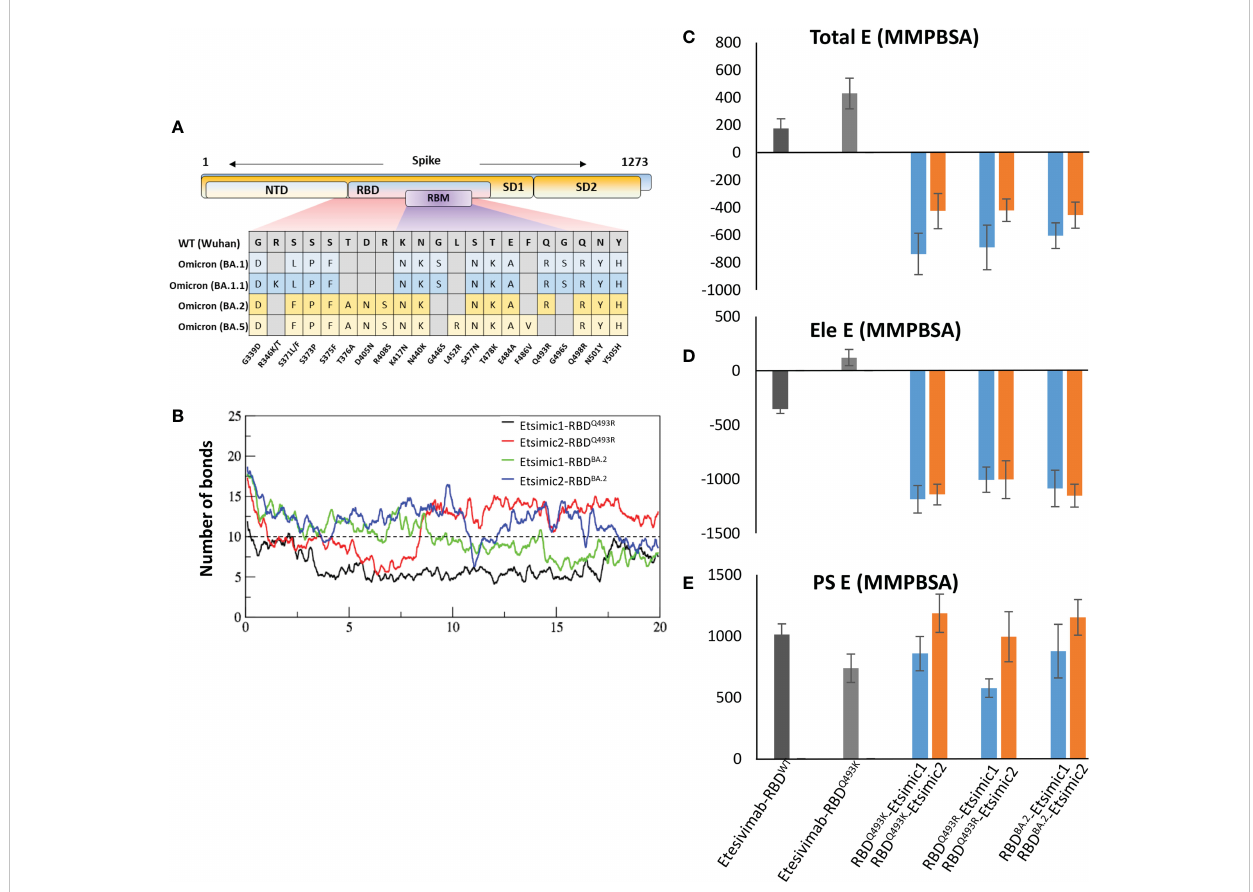
FIGURE 7 Binding free energy perturbation of the CDRs-diversi fi ed mAb (Etsimics) against Omicron BA.1 and BA.2 variants. (A) Mutations within the RBD domain of Omicron sub-variants concerning the Wuhan strain. (B) Change in the number of hydrogen bonds at the RBD BA.2 -Etsimic interface. (C-E) Relative change in the total binding free energy of the Etesevimab derivatives as calculated through the MMGBSA